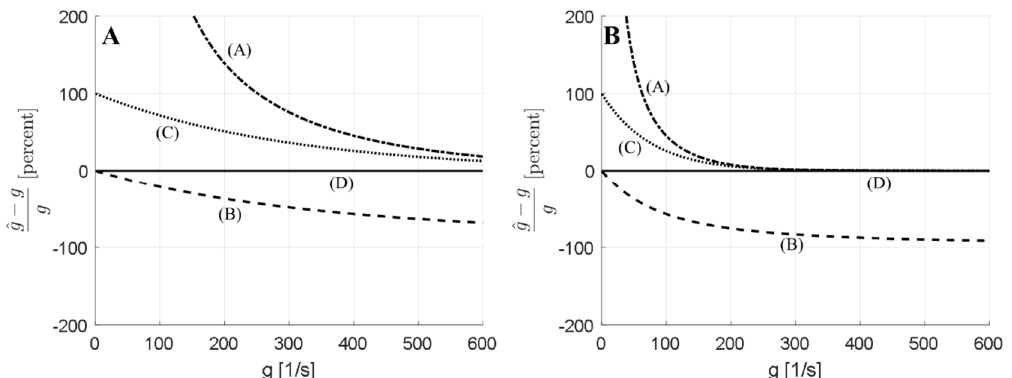
Figure 5. The systematic error obtained when estimating the breakup frequency with the different methods suggested in previous studies (A: Equation (13); B: Equation (14); C: Equation (15); D: Equation (17)), see [52] for methodology. ( A ): τ = 5 ms. ( B ) τ = 20 ms.